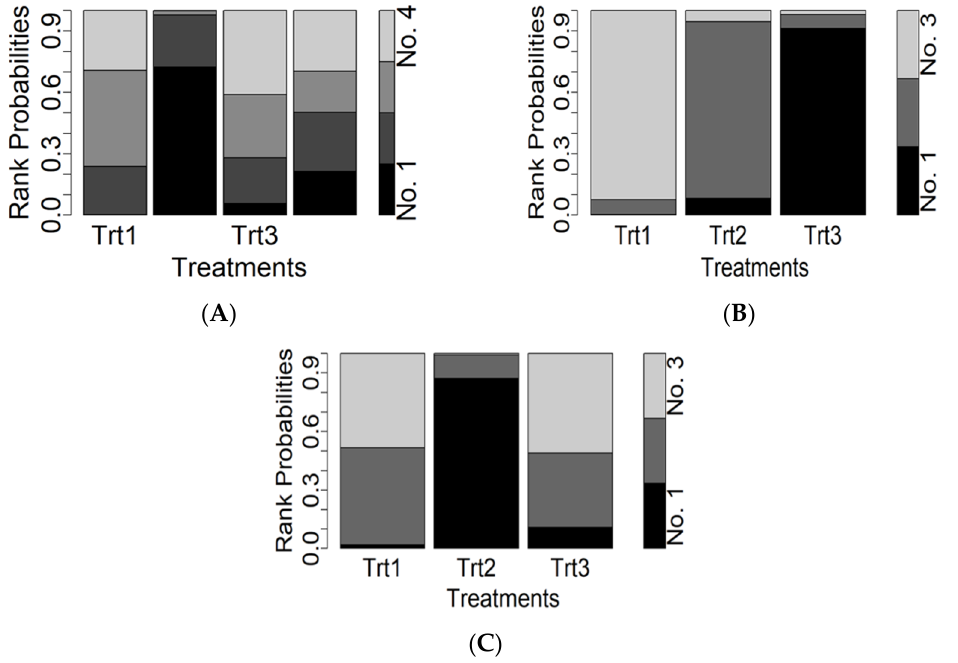
Figure 4. Plots of treatment rank probabilities for object control ( A ), locomotor ( B ), and gross motor ( C ). Trt1, reference intervention arm (control); Trt2, aerobic intervention; Trt3, exergaming intervention; Trt4, parent/teacher intervention. A darker area indicates the probability of a higher rank.